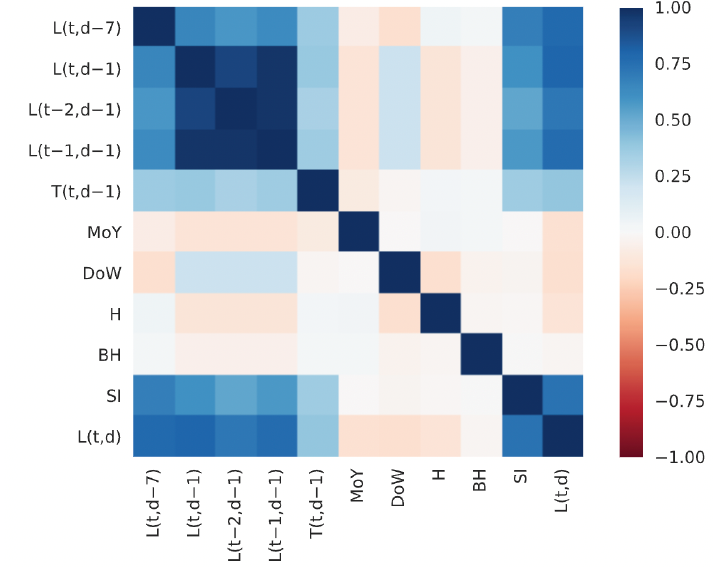
Figure 6. Correlation for all input